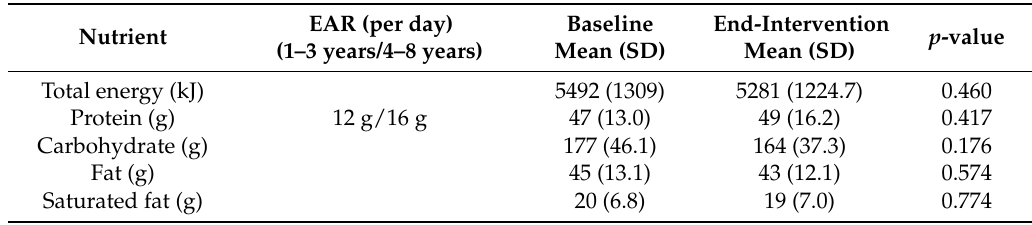
Table 2. Nutrient composition of baseline and end-intervention diets ( n = 17) and Estimated Average Requirements